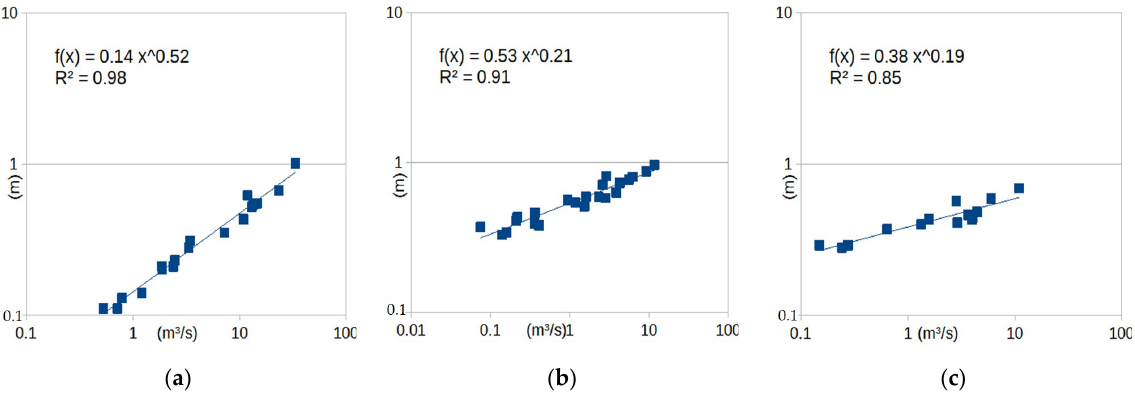
Figure 2. Sakoulevas case study—the fit of a power–law trend line to the data partitioned with PINAX: ( a ) period 1 (02/1964–05/1966); ( b ) period 2 (06/1966–05/1969); ( c ) period 3 (06/1969–01/1972).